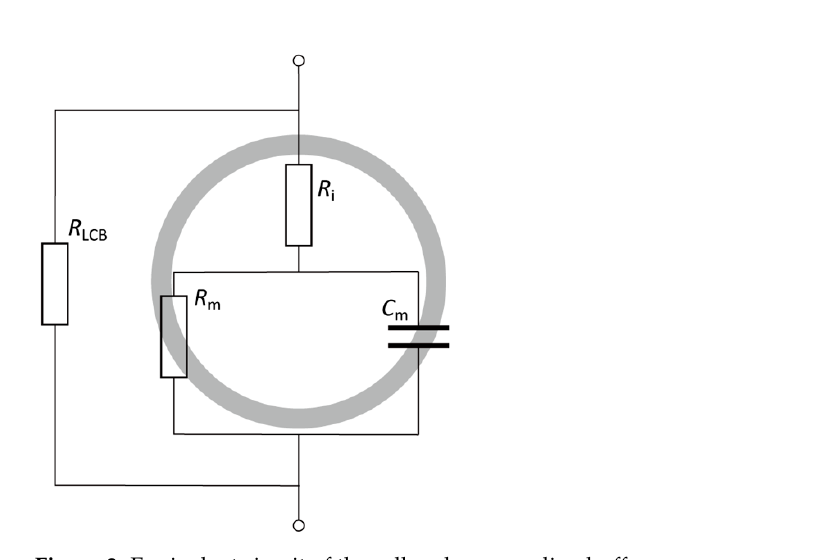
Figure 3. Equivalent circuit of the cell and surrounding buffer.